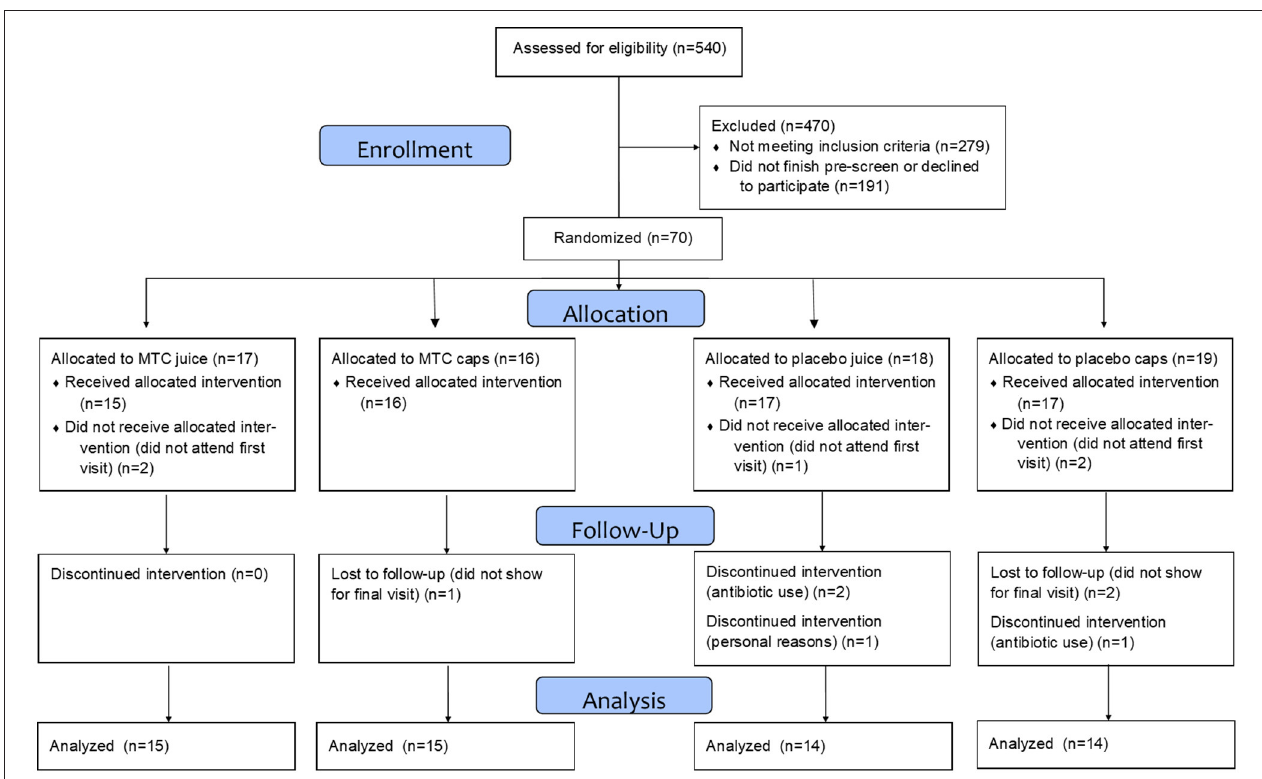
FIGURE 1 | CONSORT diagram for the